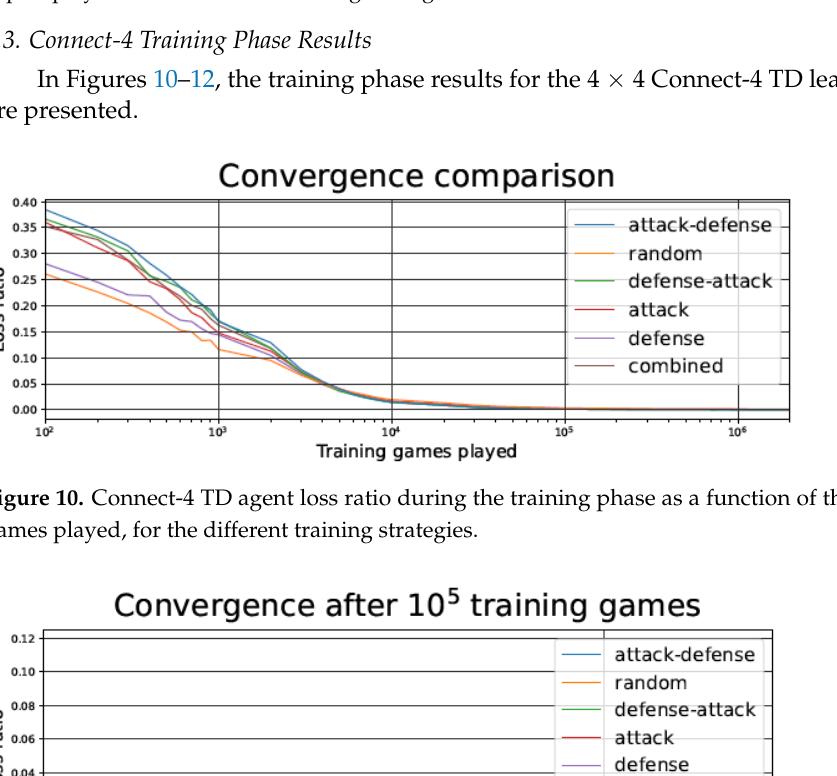
Figure 9. Percentage of test games won/lost/tied by the tic-tac-toe TD agent playing against an expert player for the different training strategies.